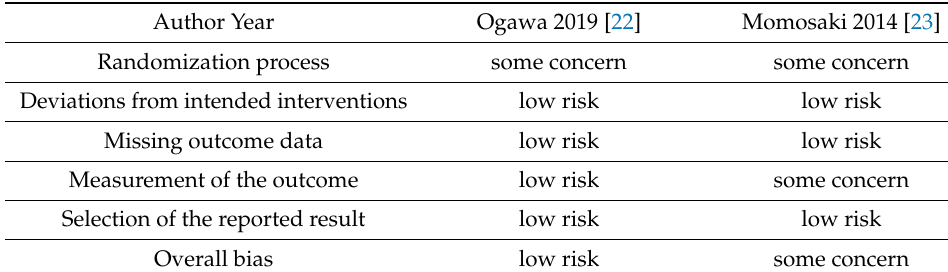
Table 1. Risk of bias summary in RCT literatures.